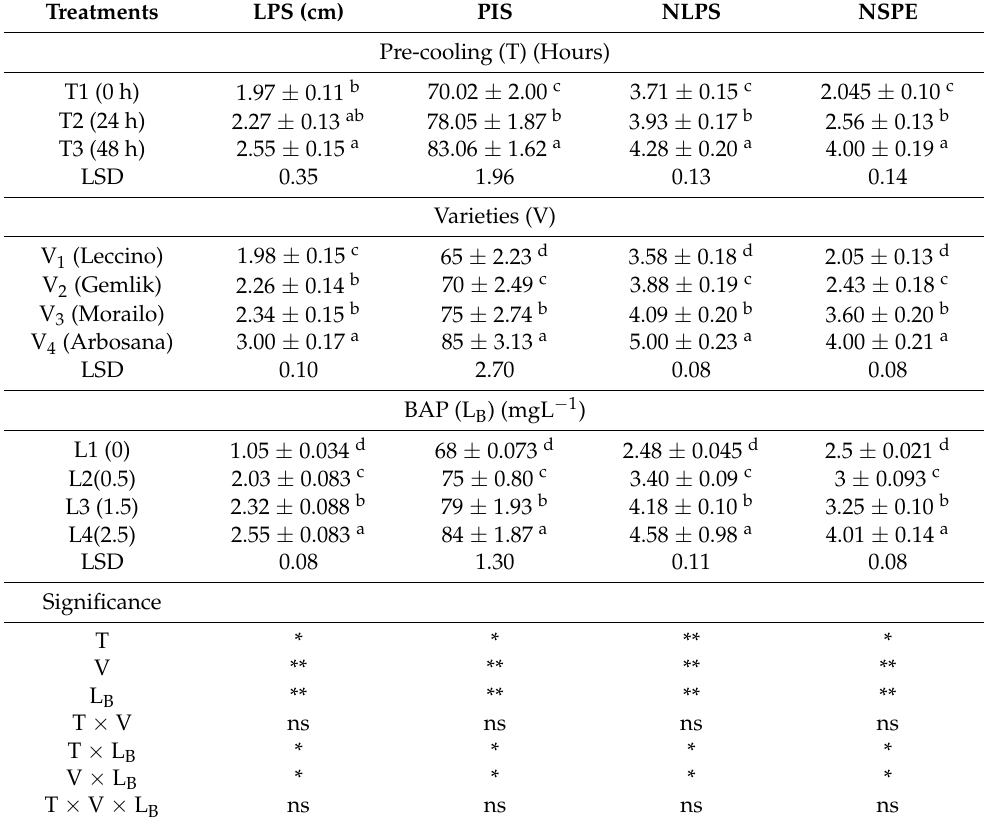
Table 1. Effect of different pre-cooling treatments and varying concentrations of BAP on growth traits of different olive ( Olea euorpea L.) genotypes cultured within micropropagation system using OM. Treatments LPS (cm) PIS NLPS NSPE Pre-cooling (T)